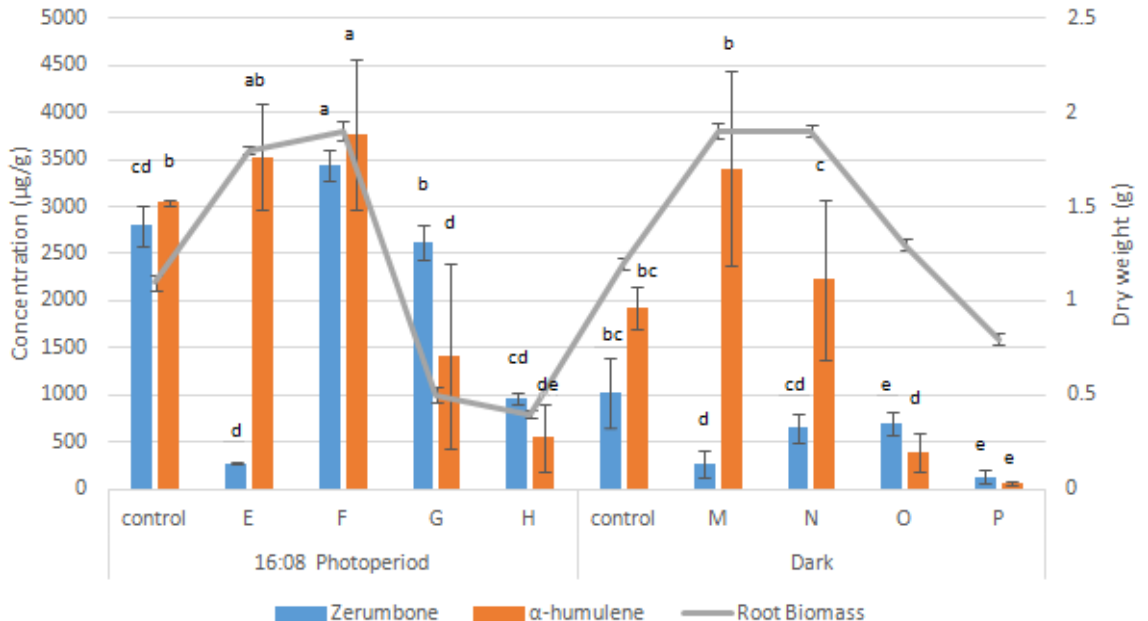
Figure 5. Zerumbone, α -humulene, and root dry weight produced in a combined auxin–cytokinin medium with a 16:08 photoperiod and dark condition. MS media supplemented with 1 mg/L NAA (control) combined with 1, 3, 5, and 7 mg/L BAP (treatments E, F, G, and H, respectively, with a 16:08 photoperiod) or with 1 mg/L NAA (control) added with 1, 3, 5 and 7 mg/L BAP (treatments M, N, O, and P in the dark, respectively). Error bars indicate standard deviation of the mean value. Means with different letters in the same column are significantly different at p < 0.05 according to ANOVA and Tukey’s multiple range test .